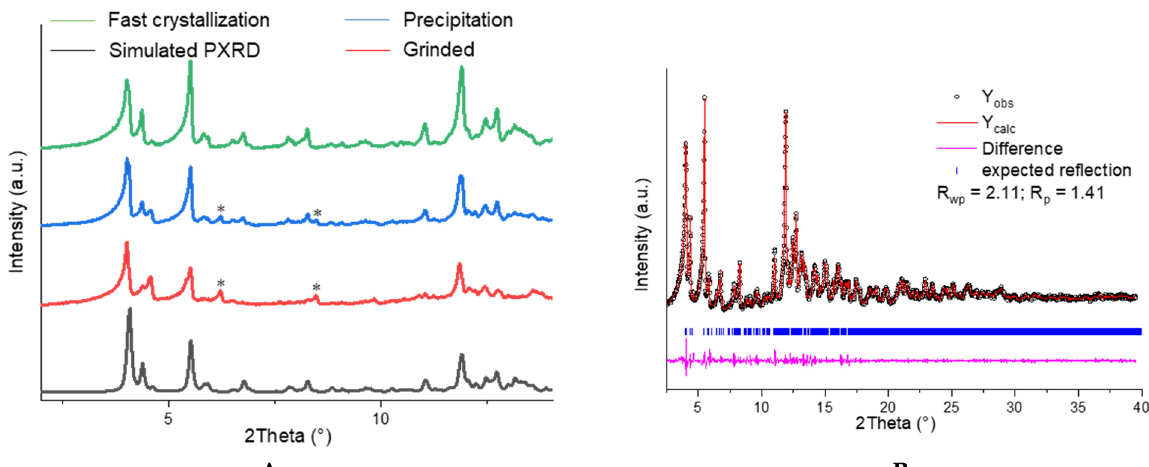
Figure 5. ( A ) Powder diffractograms ( λ = 0.7093 Å) measured of samples obtained after fast crystallization (green), precipitation (blue), and grinded powder (red) at ambient conditions. A simulated pattern was generated from SC-XRD of polymorph α (black). ( B ) Pawley fit analysis of fast crystallization powder and calculated data. Observed data sets and calculated data are shown in black symbols and red line, respectively. The pink line shows the difference curve, while the blue marks show Bragg positions.